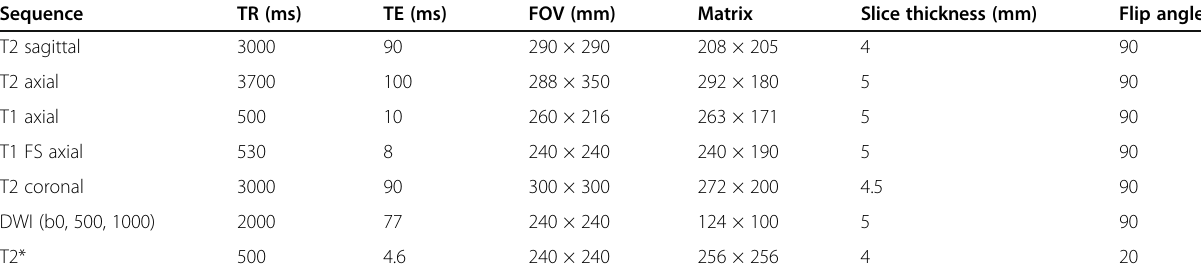
Table 1 MRI protocol performed in the current study